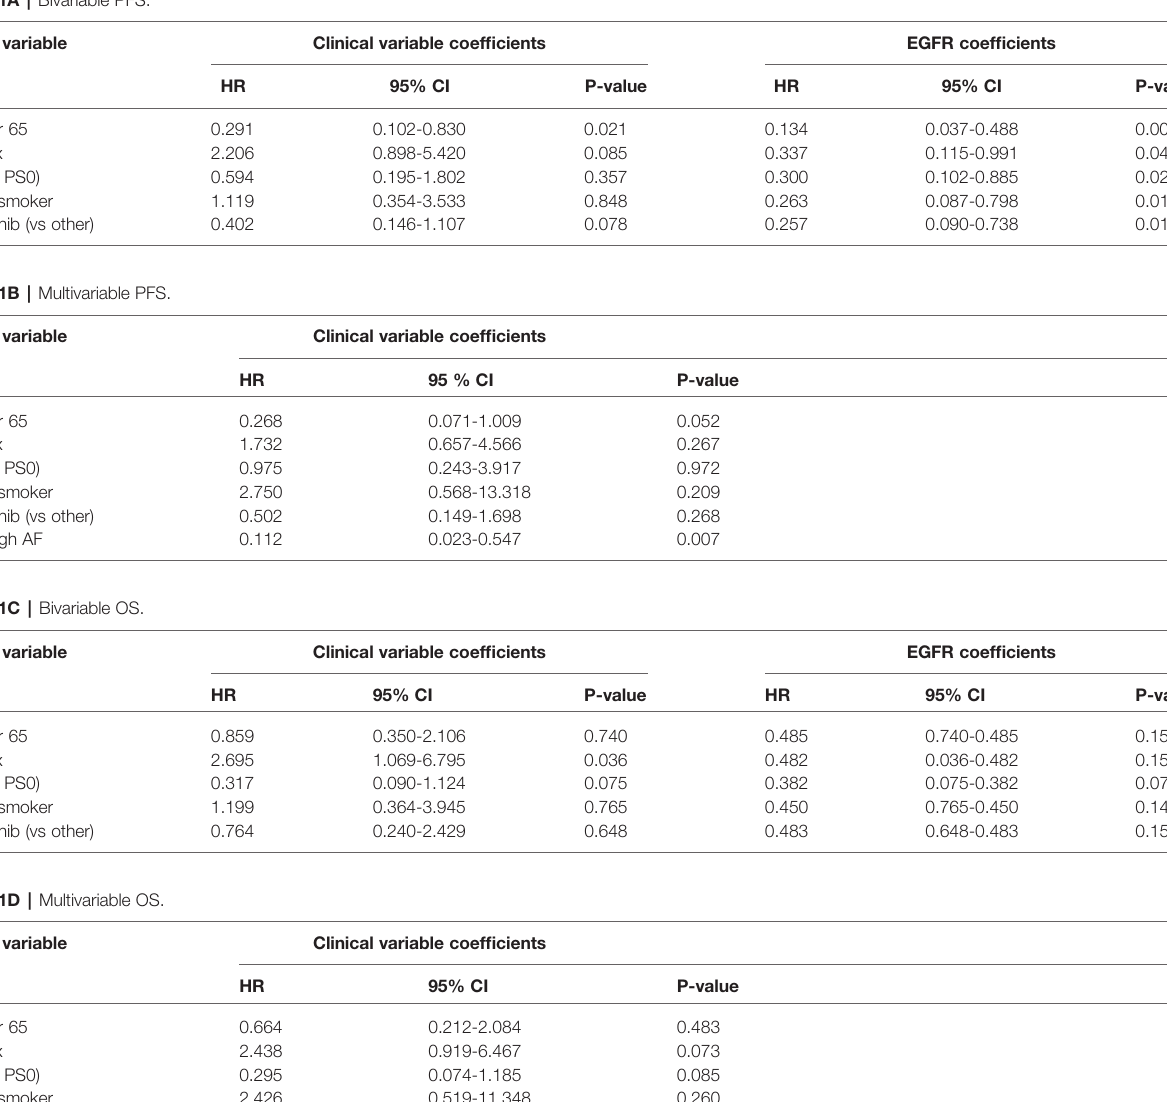
TABLE 1A | Bivariable PFS.